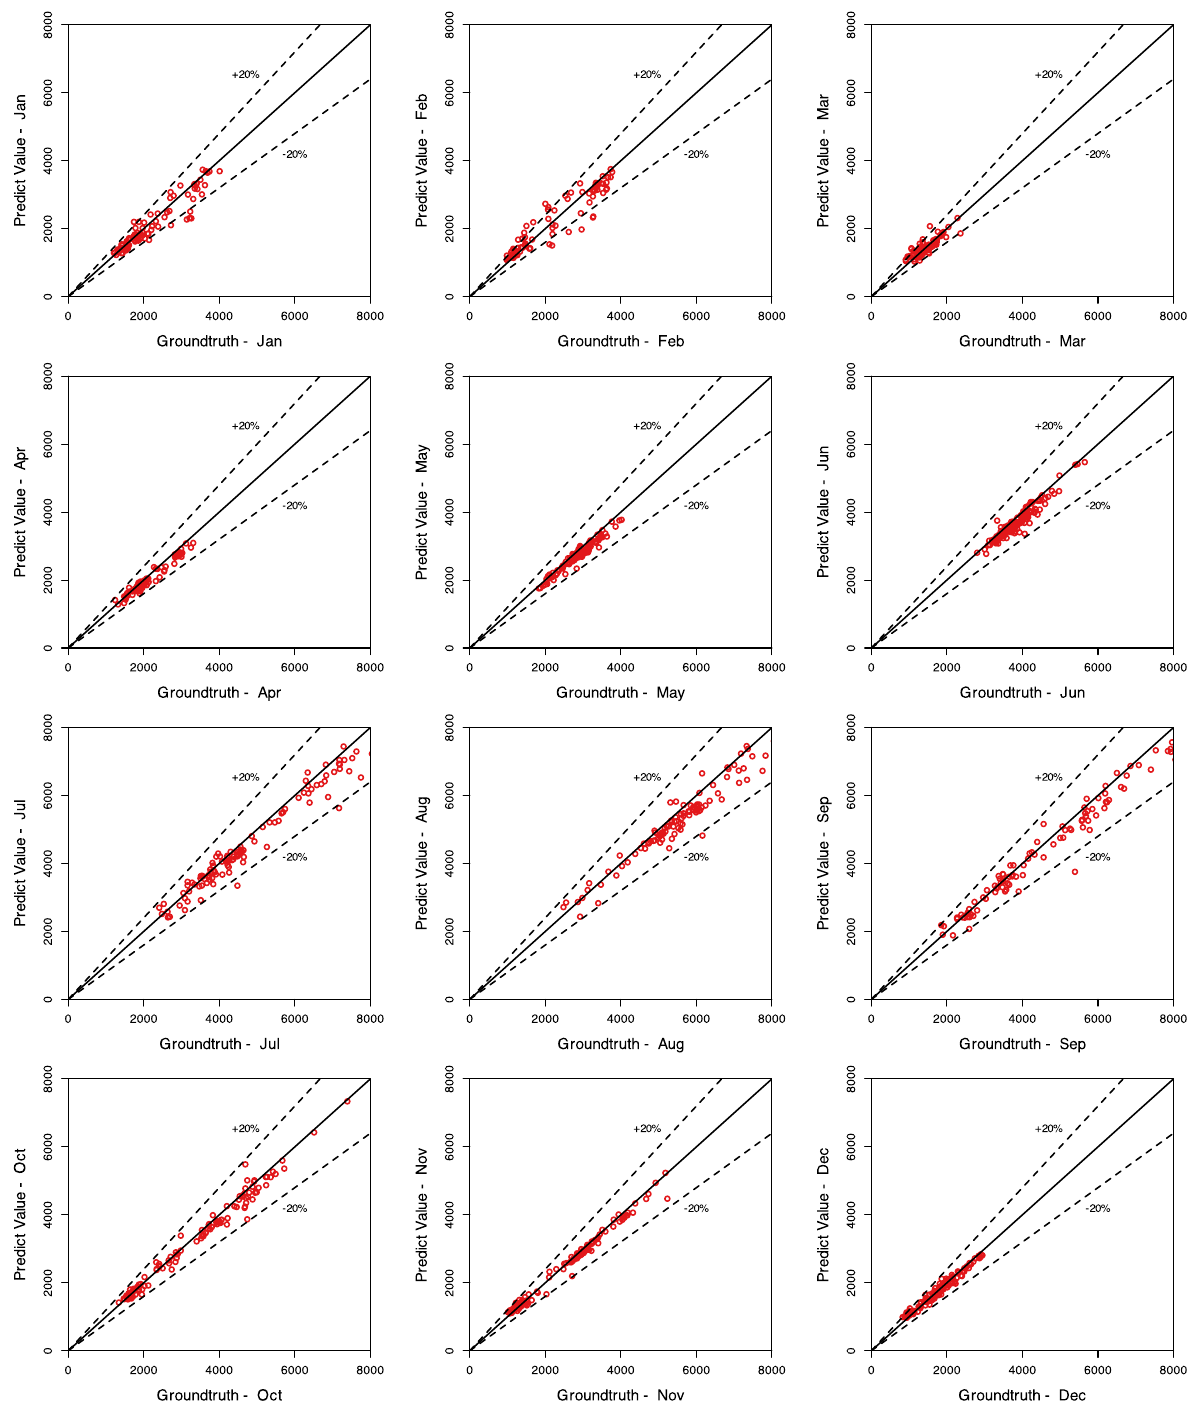
Figure 20. Scatter plot comparing observed and one-step ahead prediction for each month made by Ensemble SSA GA on Son Tay the Son Tay dataset’s discharge level from 2016 to 2019. We scatter the ground truth versus the Ensemble SSA GA’s prediction results in Fig. 20). In each plot, there is the best fit line (i.e., the black solid diagonal line) and a ± 20% relative error band (i.e., black dashed line). The Ensemble SSA GA model’s forecasts remain within two error bands and are highly concentrated around the best fit line across all of these plots. Notably, the months are divided into two groups. The former involves the flood season, which lasts from July to November, and the latter covers the rest of the year. It can be seen that the value range of the ground truth is quite stable for the group of regular months (not during the flood season), making it more predictable. Furthermore, the model’s predictions